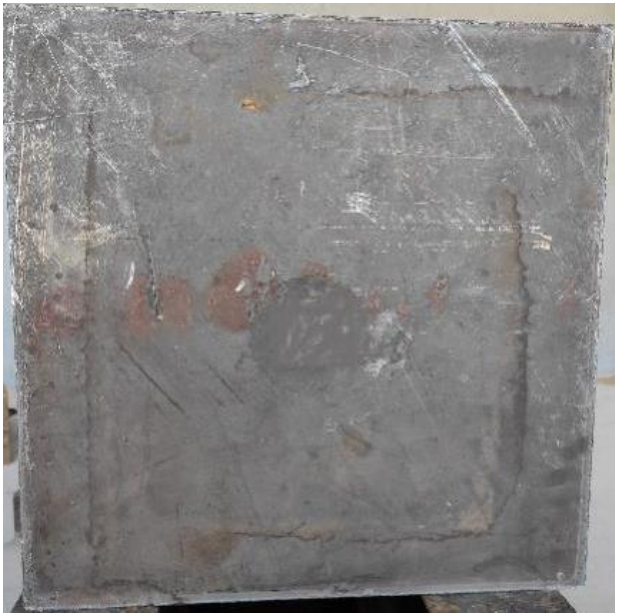
Figure 8. Rear face of the target